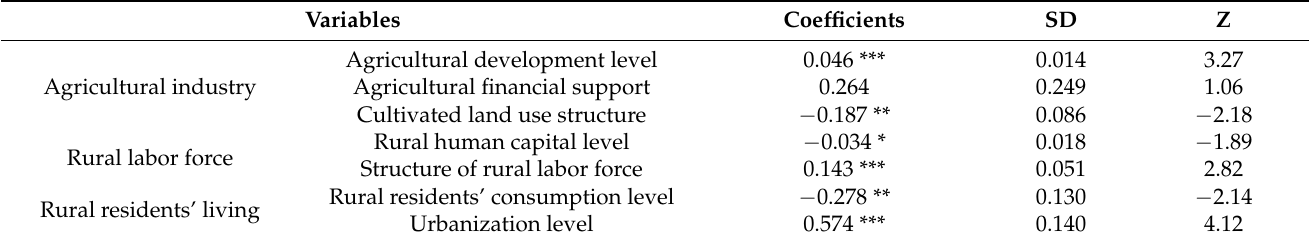
Table 4. Estimation results of factors influencing rural energy carbon emission